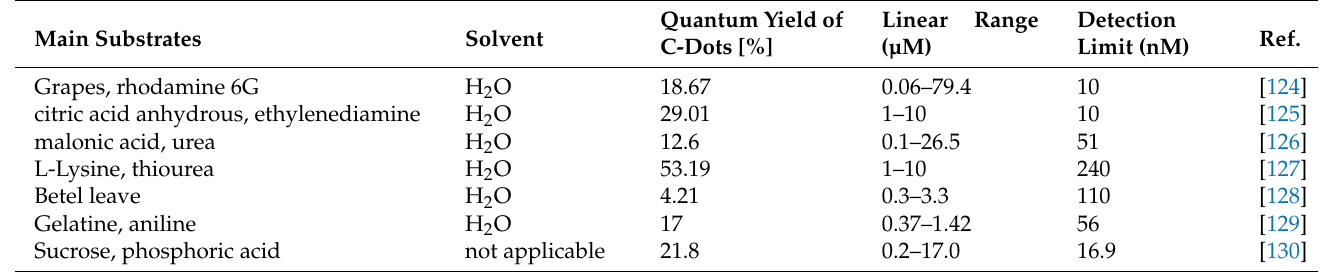
Table 5. Summary of materials used for C-dot fabrication and their picric acid detection performance.